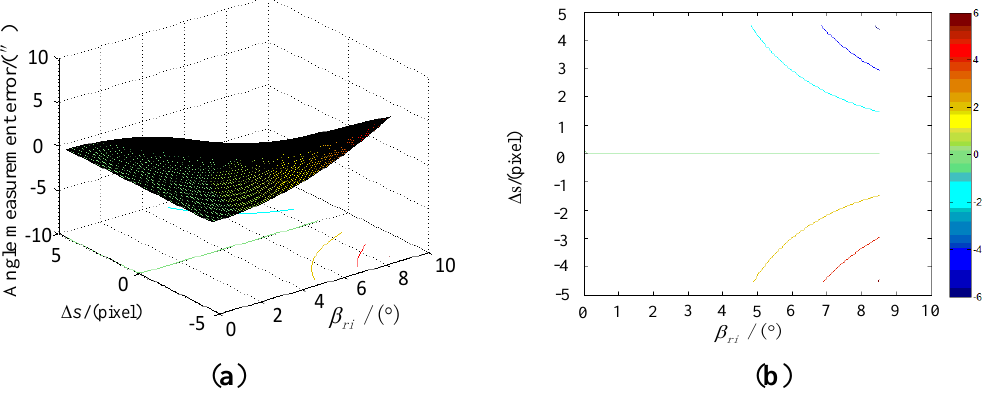
Figure 5. Influence of the principal point error on the star tracker accuracy. ( a ) is obtained when ∆s is among the range from −4.5pixels to 4.5 pixels; ( b ) is the contour line of (a).